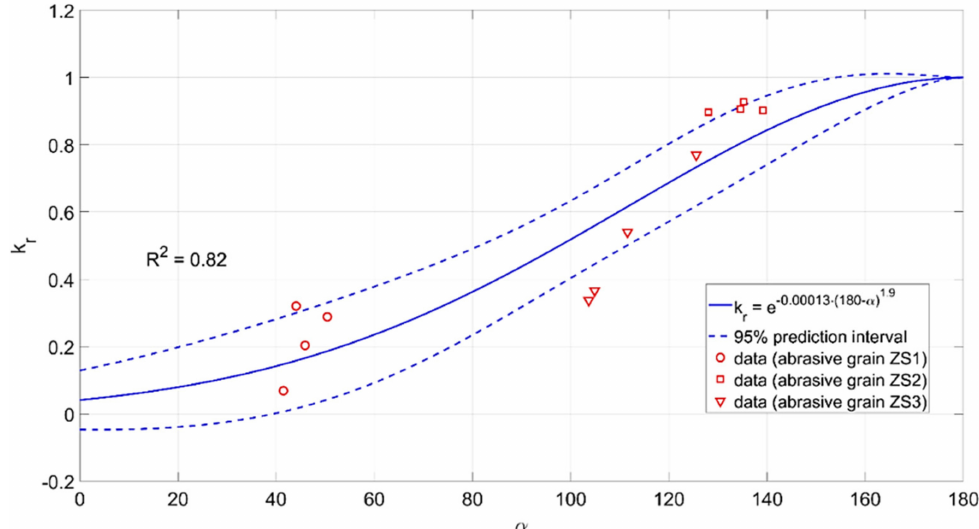
Figure 21. Influence of the opening angle α of the abrasive grain on the material removal efficiency k r